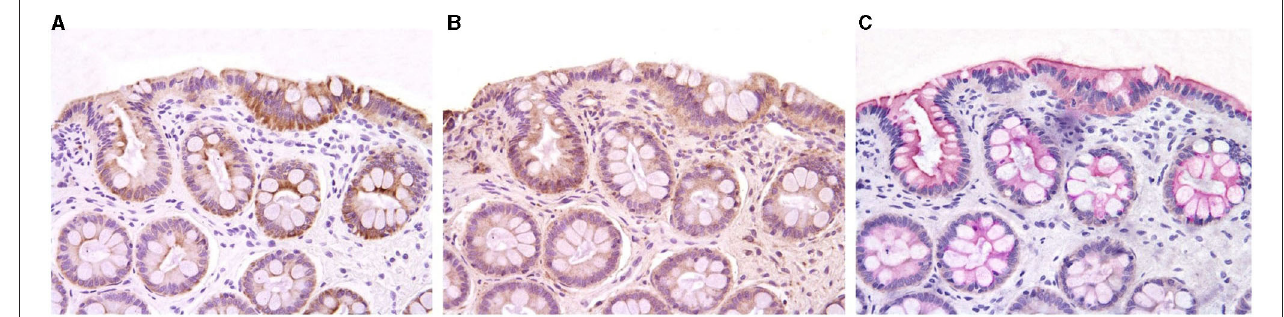
FIGURE 6 | Immunohistochemistry for expression of tight junction proteins in colonic biopsies of healthy dogs and dogs with CIE before and after probiotic VSL #3 therapy. Healthy dogs generally express increased TJPs as compared to dogs with CIE at diagnosis (pre-VSL #3). A reciprocal increase in TJP expression is observed in dogs with CIE following probiotic treatment (post-VSL #3). (A) Claudin expression; (B) E-cadherin expression; (C) Occludin expression. All images at 20X magnification. From: White et al. (141), with